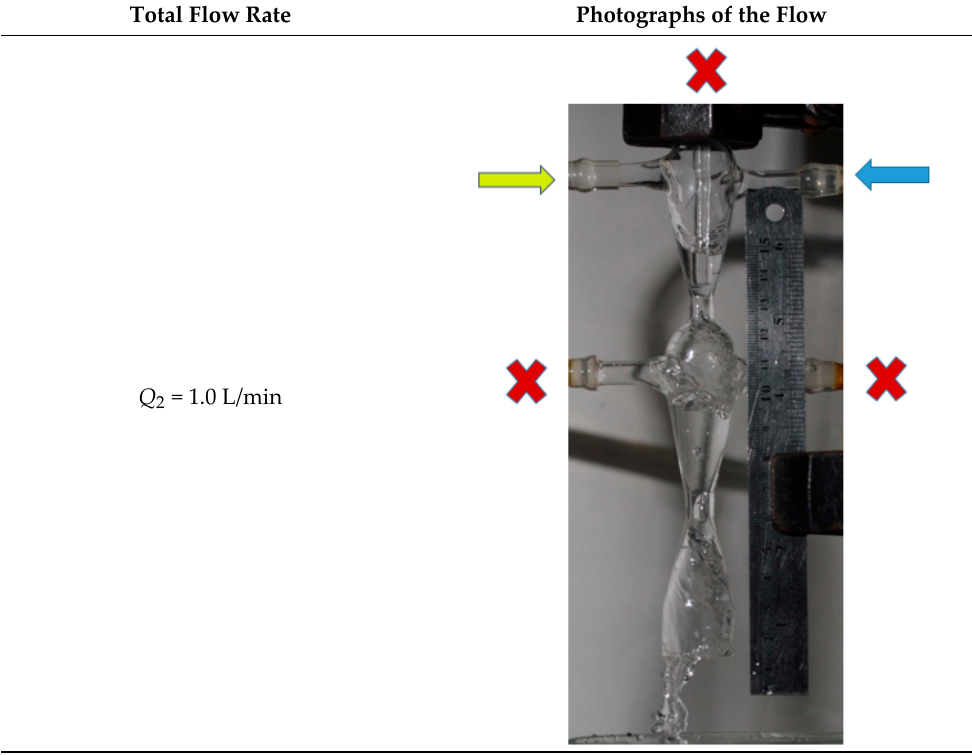
Table A1. Photographs of the flow in MRISF ‐ 2 for liquids supply method (TU1, TU2). Total Flow Rate Photographs of the Flow